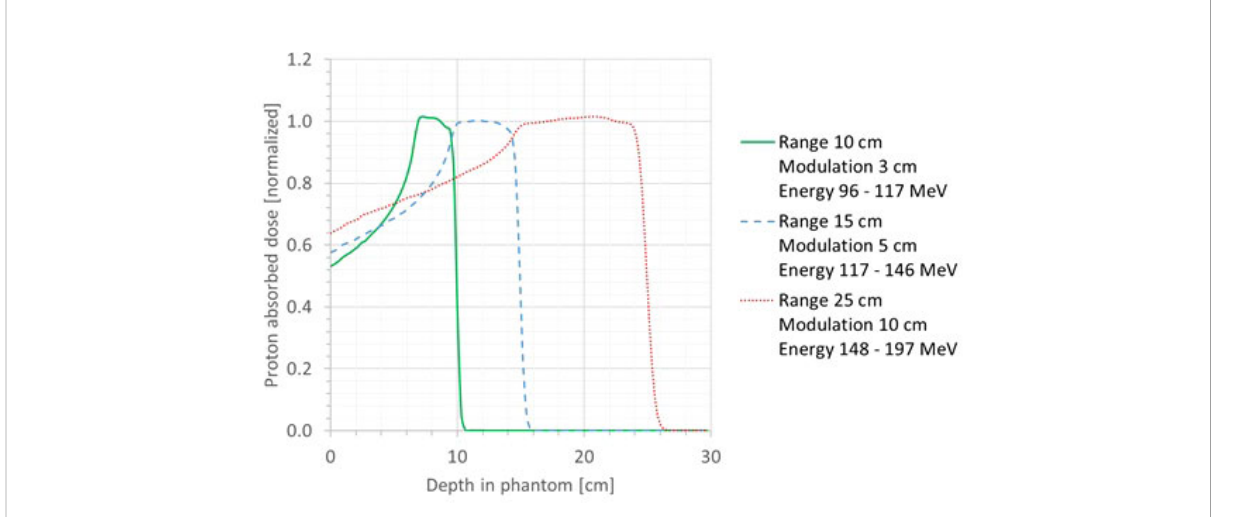
FIGURE 4 Plot of the simulated SOBP pro fi les for three different cases: range, 10 cm; modulation width, 3 cm (green full line); range, 15 cm; modulation width, 5 cm (blue dashed line); range, 25 cm; modulation width, 10 cm (red dotted